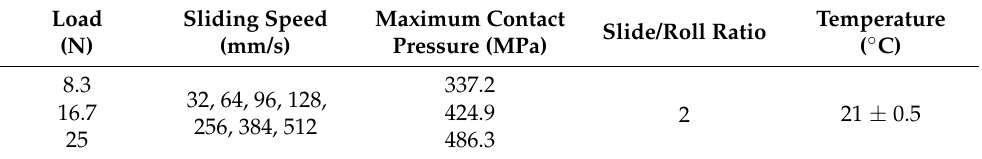
Table 4. Parameters of samples.